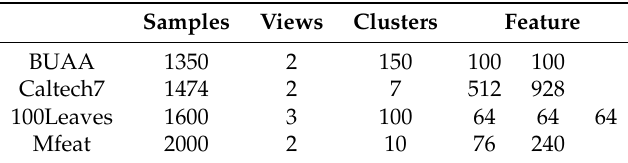
Table 1. Statistics of the datasets.